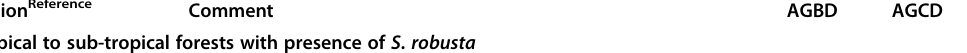
Table 6 Comparative review between biomass and carbon stock estimates in similar forest types reported under previous investigations and the present study Region